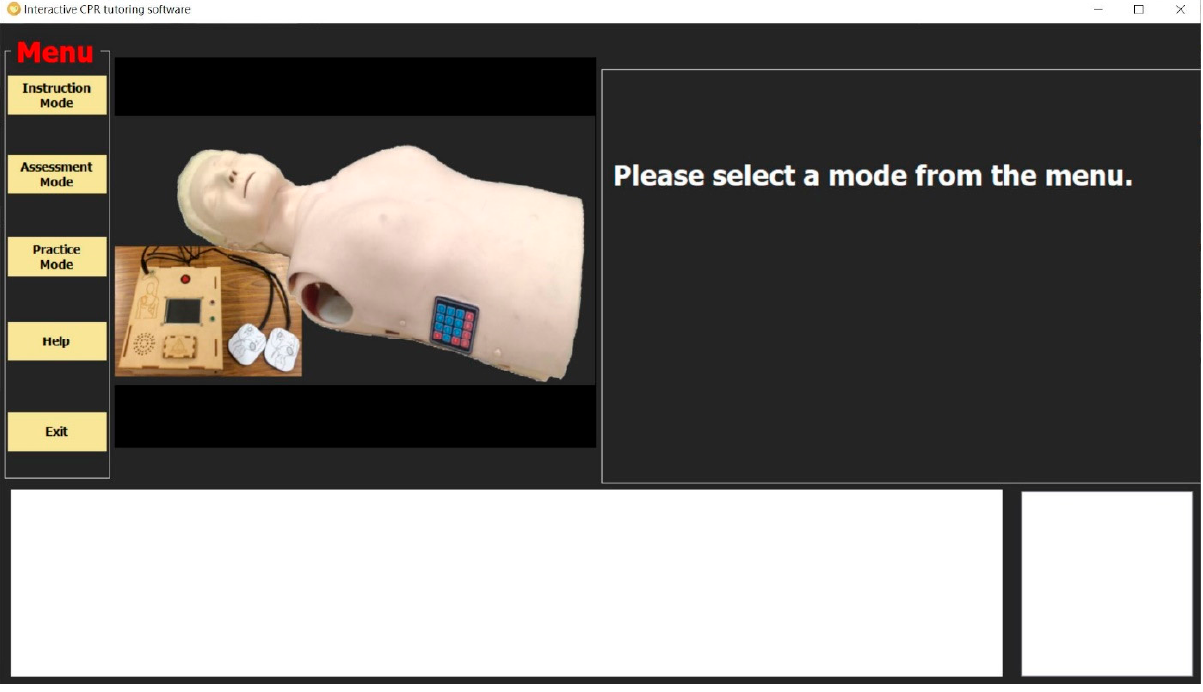
Figure 11. The user interface of the interactive CPR tutoring software.